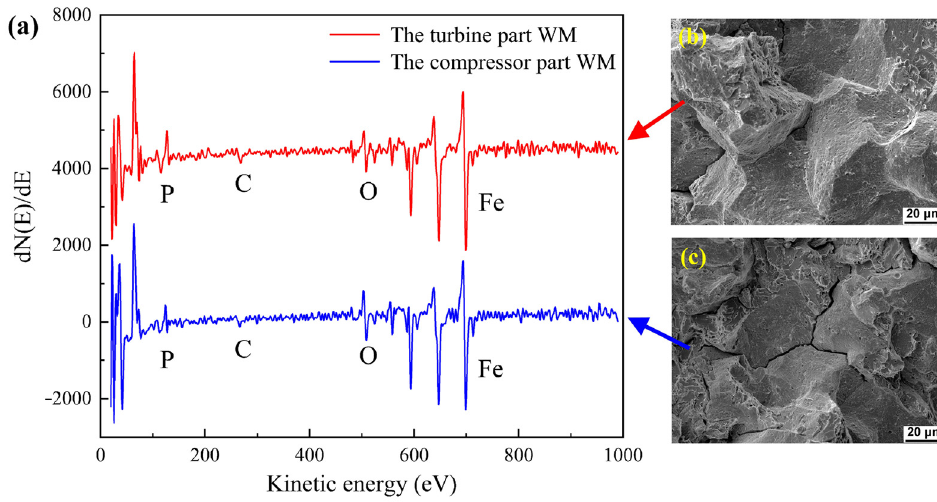
Figure 11. The Auger analysis results of the WMs: ( a ) Auger electron spectroscopy; ( b ) the fracture surface of AES specimens in the turbine part WM; ( c ) the fracture surface of AES specimens in the compressor part WM. The C and O peaks were due to the contamination in the AES chamber.